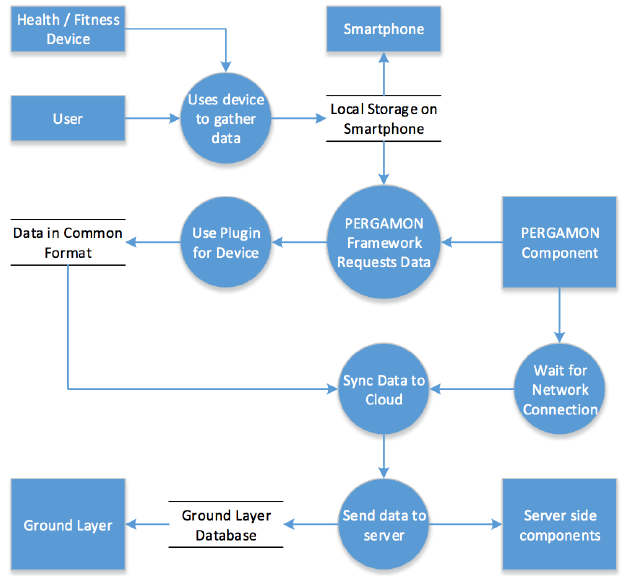
Figure 2. The data flow of the Sensor